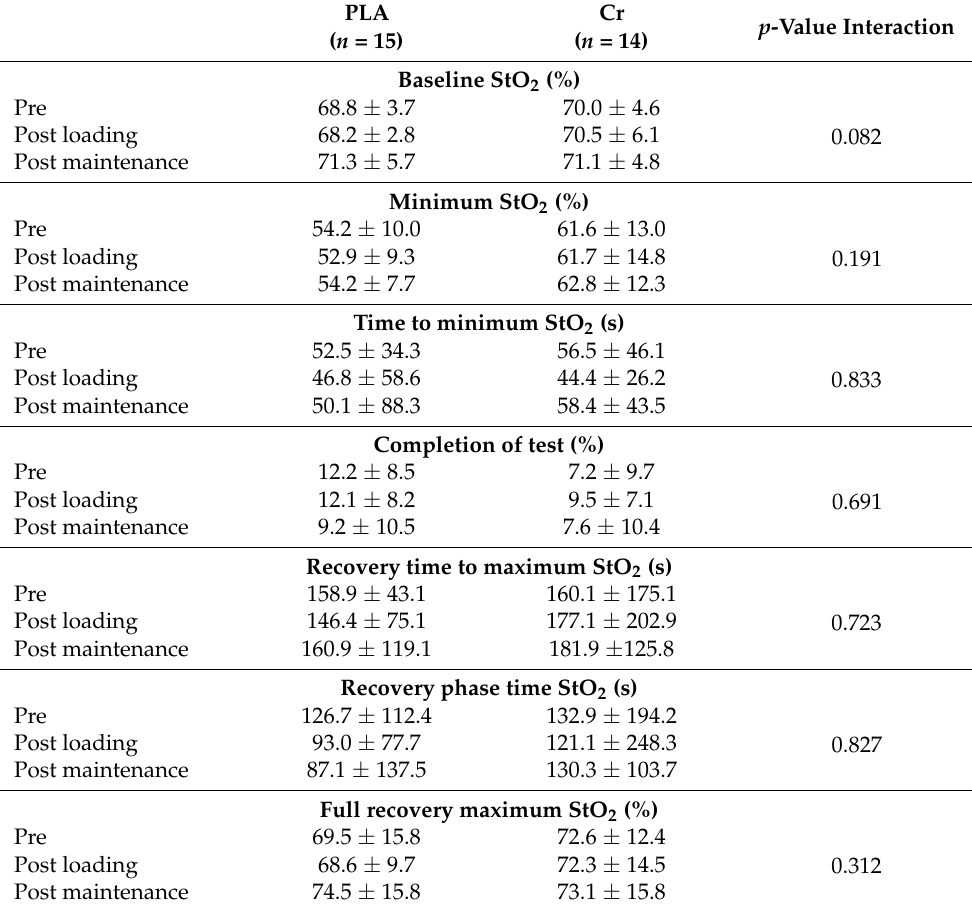
Table 2. Calf muscle StO 2 data before (pre) and after the short period (post loading) and long period (post maintenance) of supplementation ( n =